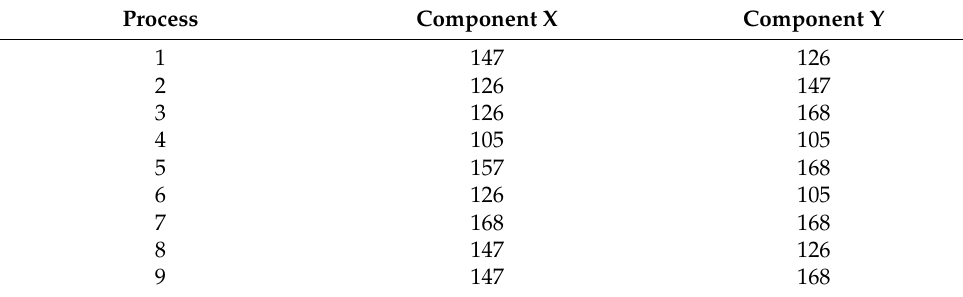
Table 3. Component-assembly process and